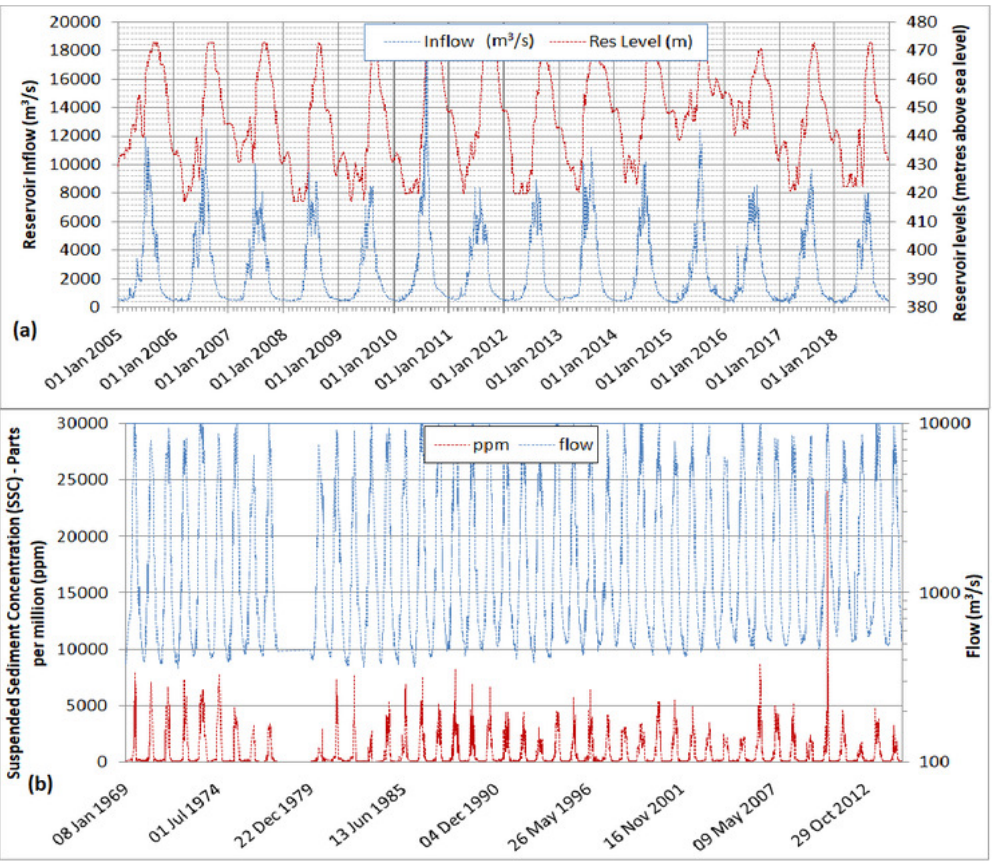
Figure 2. Data used in the study: ( a ) daily Tarbela Reservoir inflow and levels; ( b ) occasionally-collected suspended sediment concentration samples with observed